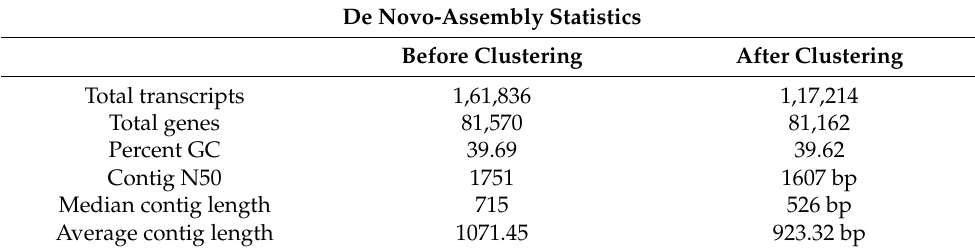
Table 2. De novo-assembly statistics of A. glauca transcriptome. De Novo-Assembly Statistics